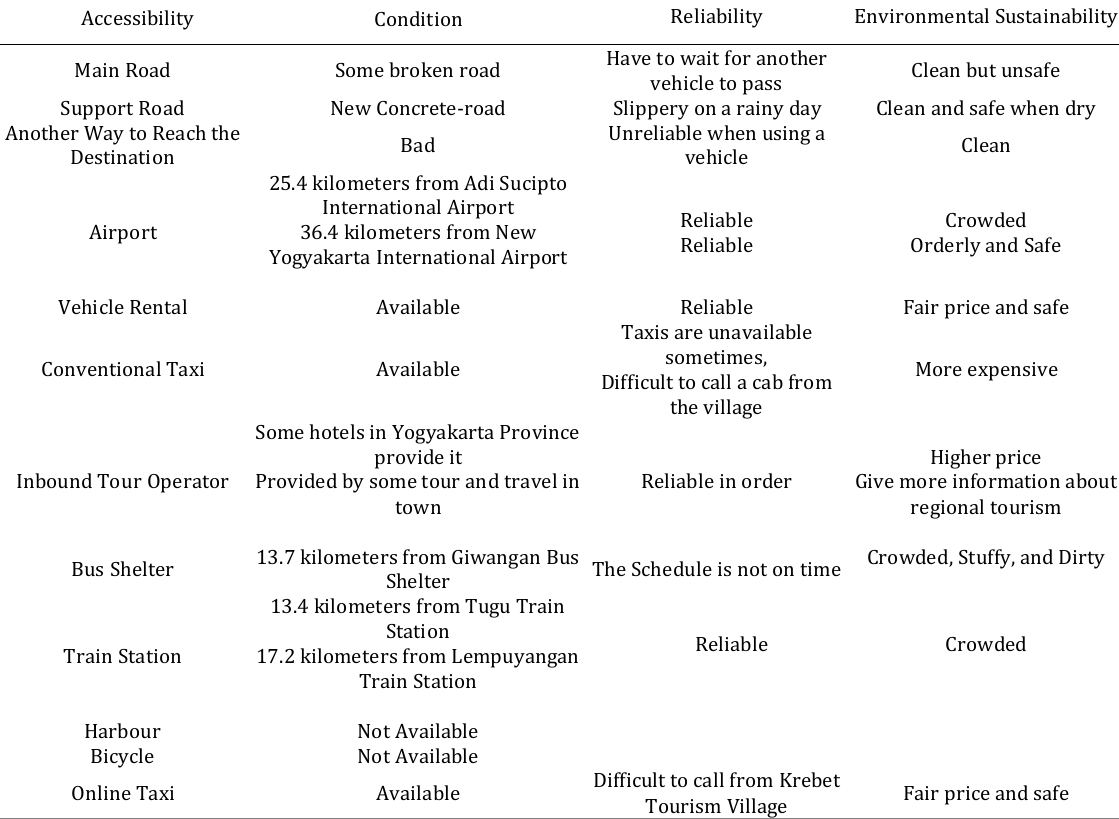
Table 2 Accessibilities to Krebet Tourism Village